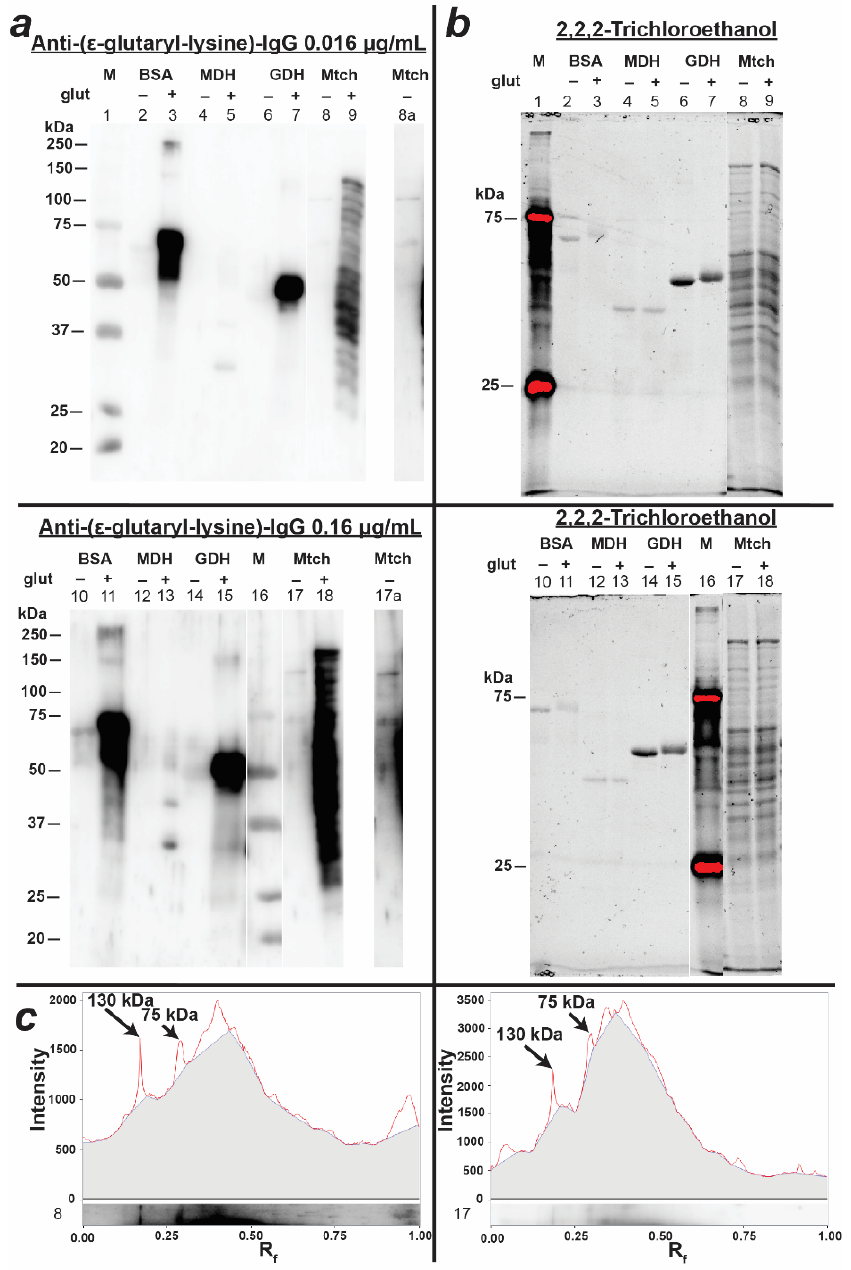
Figure 3. Immunovisualization of glutarylation of purified proteins and proteins of the extract of liver mitochondria, prepared from male rats aged 10–12 weeks. The results of incubation of PVDF membranes with anti-( ε -glutaryl-lysine) antibodies at 0.016 µg/mL and 0.16 µg/mL concentrations ( a ) and total protein in the corresponding gels, assessed by 2,2,2-trichloroethanol staining ( b ). Lane numbers correspond to the following samples: 1, 16—protein markers (M) with known molecular weights indicated to the left of the blots; 2, 10—untreated bovine serum albumin (BSA); 3, 11—glutarylated BSA; 4, 13—untreated malate dehydrogenase (MDH); 5, 13—glutarylated MDH; 6, 14—untreated glutamate dehydrogenase (GDH); 7, 15—glutarylated GDH; 8, 17—untreated extract of liver mitochondria (Mtch); 9, 18—glutarylated mitochondrial liver extract; 8a, 17a—contrast images of lanes 8, 17 for better visualization of bands with molecular weights of 75 and 130 kDa. ( c ) Densitograms of the untreated extract of liver mitochondria (lanes 8 and 17); the arrows show the peaks corresponding to the proteins mentioned in the text with molecular weights of 75 and 130 kDa; grey color corresponds to the background staining from adjacent lanes (9 and 18).